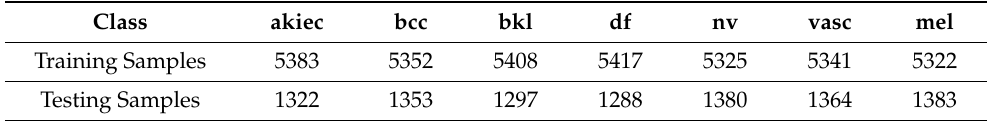
Table 6. Class-wise images present in HAM10000 dataset with